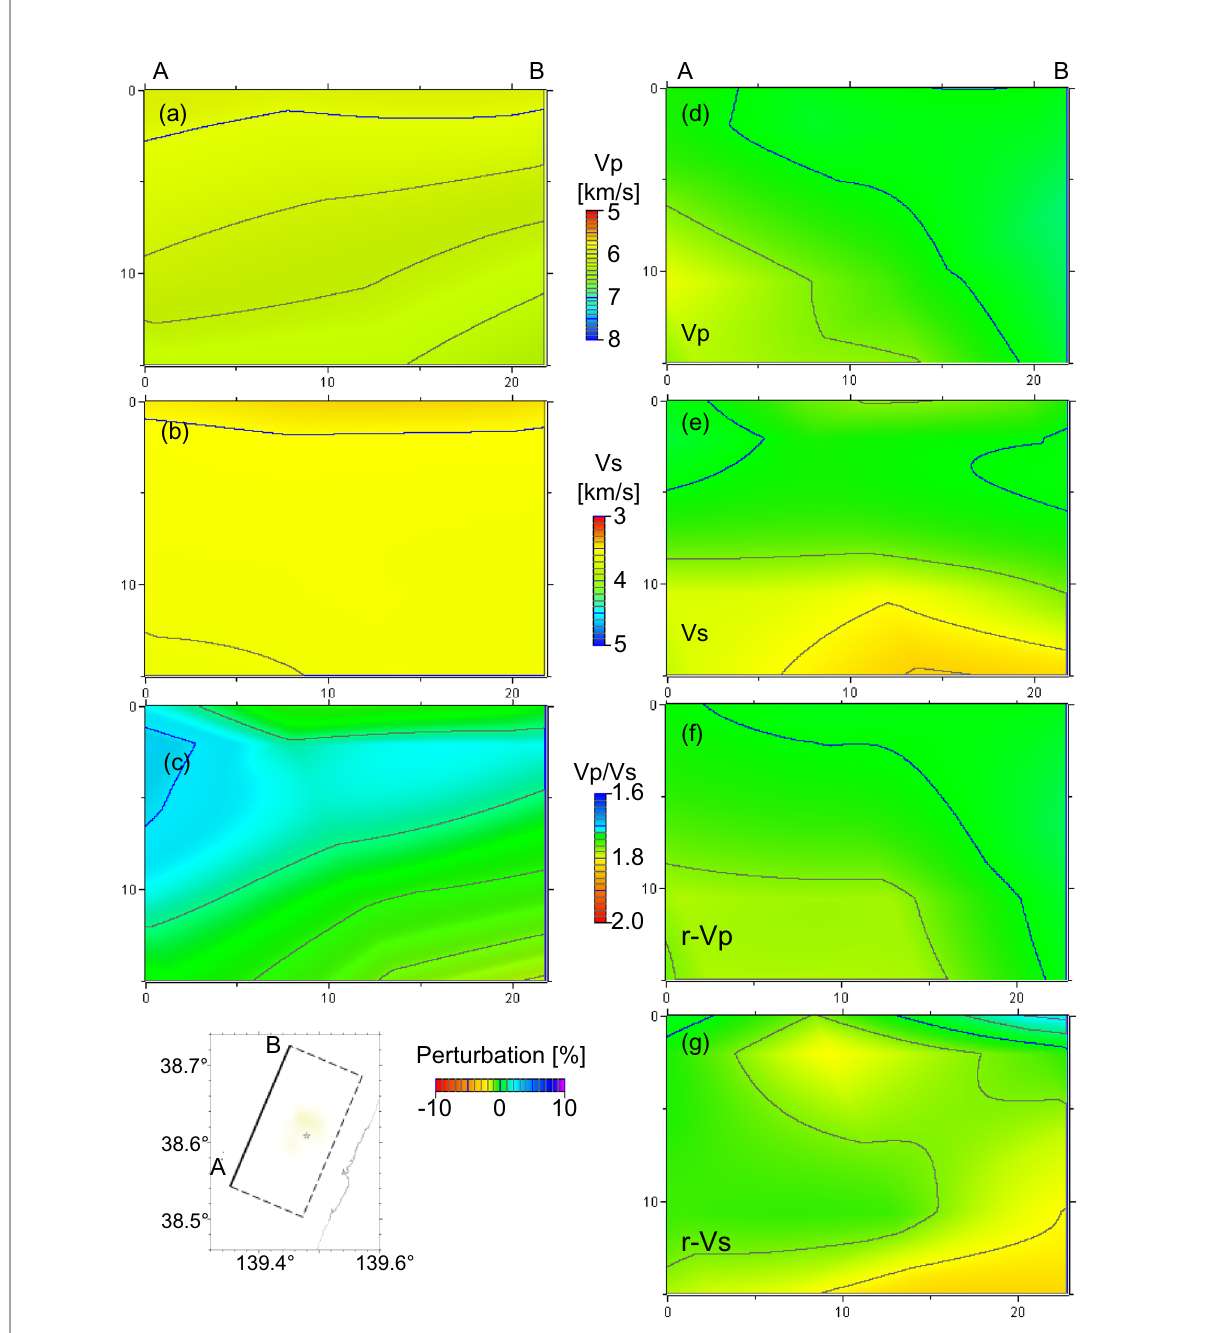
Fig. 21 Seismic velocity structure and restored resolution test along the coseismic slip region of the 2019 offshore Yamagata